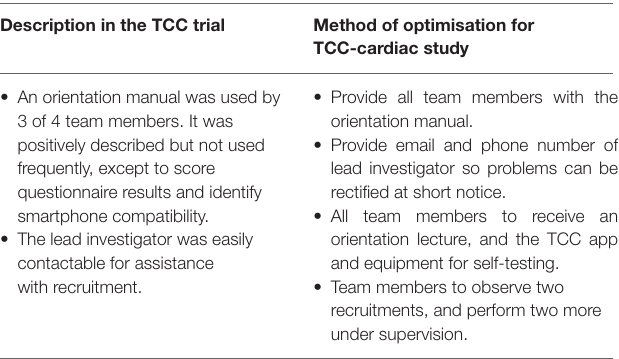
TABLE 5 | Features of the training process for TCC team members. Description in the TCC trial Method of optimisation for TCC-cardiac